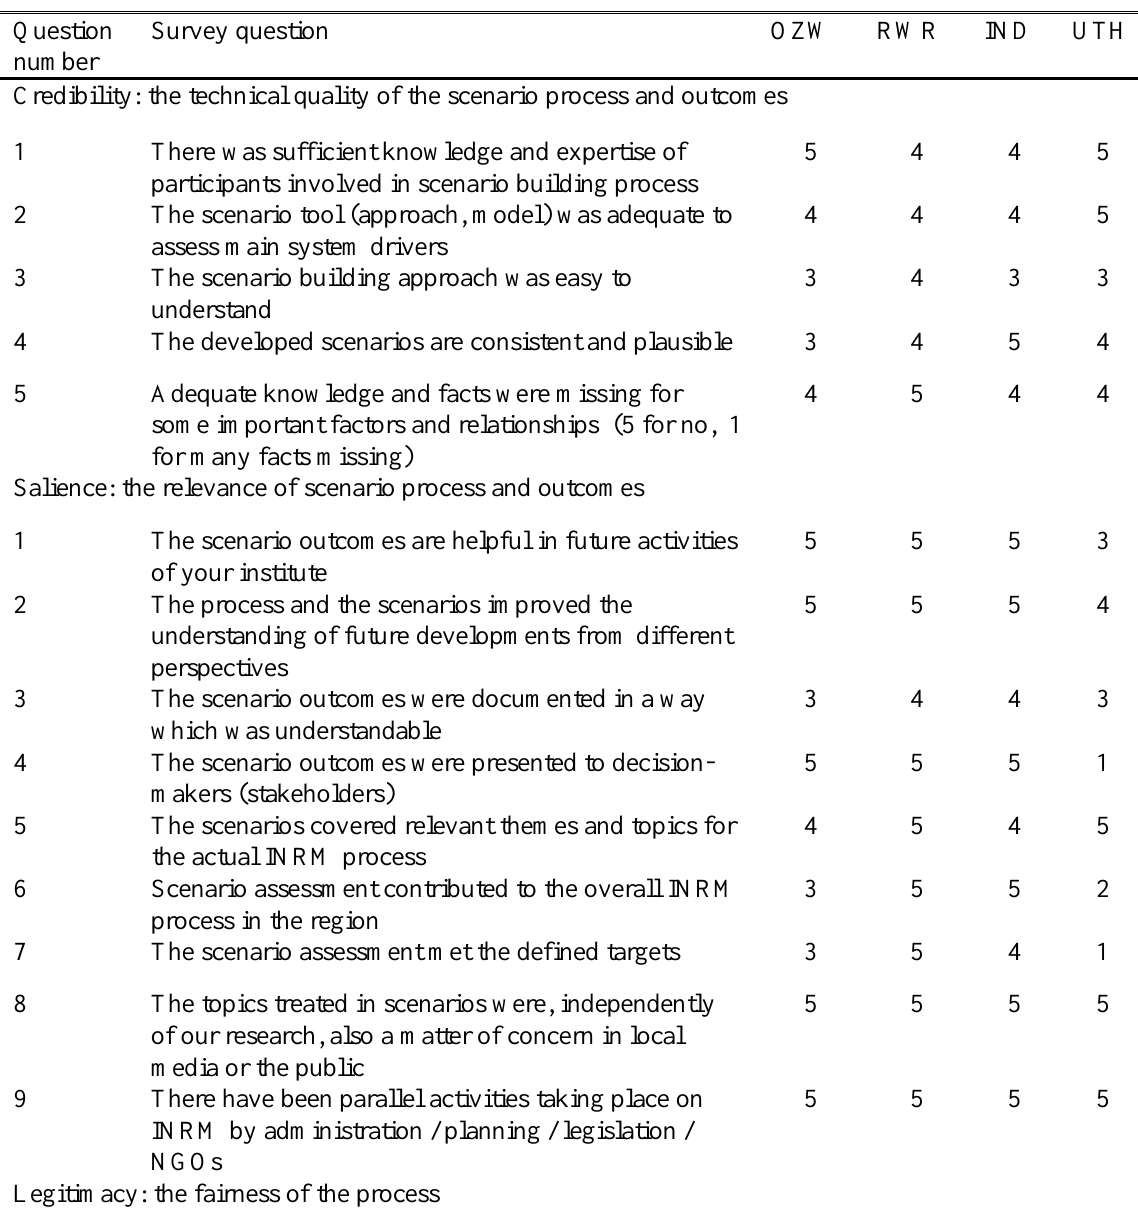
Table A2.2: Survey of local researchers on the usefulness of the scenario process and outcomes for sustainability research to feed into the INRM process in the case studies. The scores represent the overall evaluation of each group of researchers. They are on an ordinal scale from 1 to 5 with 1: I absolutely do not agree, 2: I do not agree, 3: I partially agree, 4: I agree, and 5: I fully